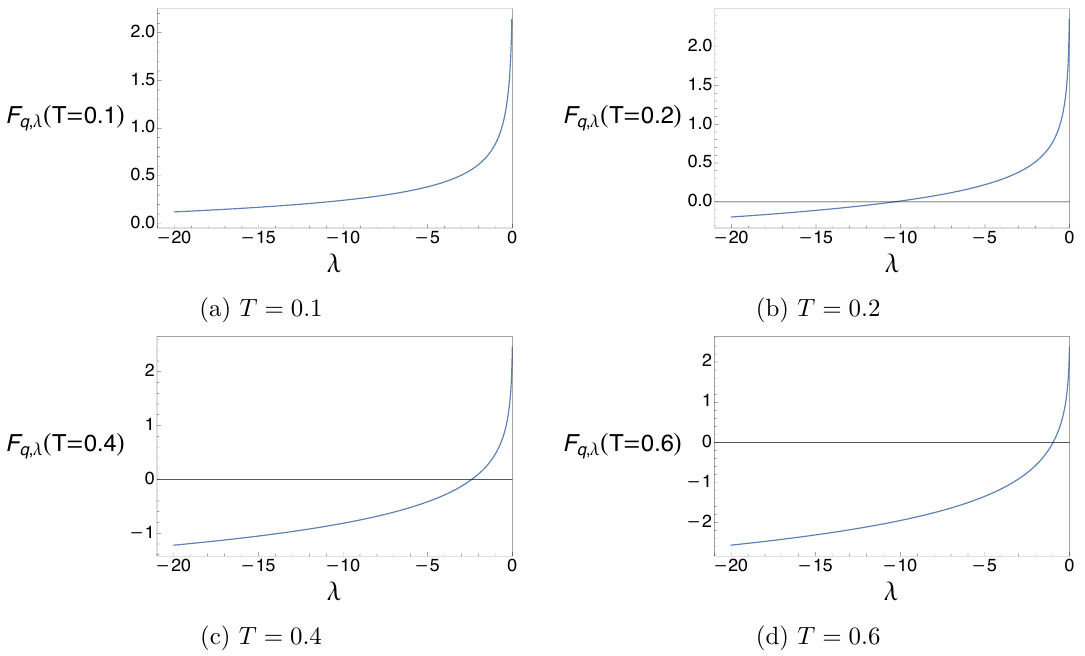
Figure 9. We plot the quenched free energy F q,λ ( T ) without the contribution from the non- perturbative branch as a function λ for fixed T = 0 . 1 , 0 . 2 , 0 . 4 , 0 . 6 . As shown, F decreasing as | λ | increases.